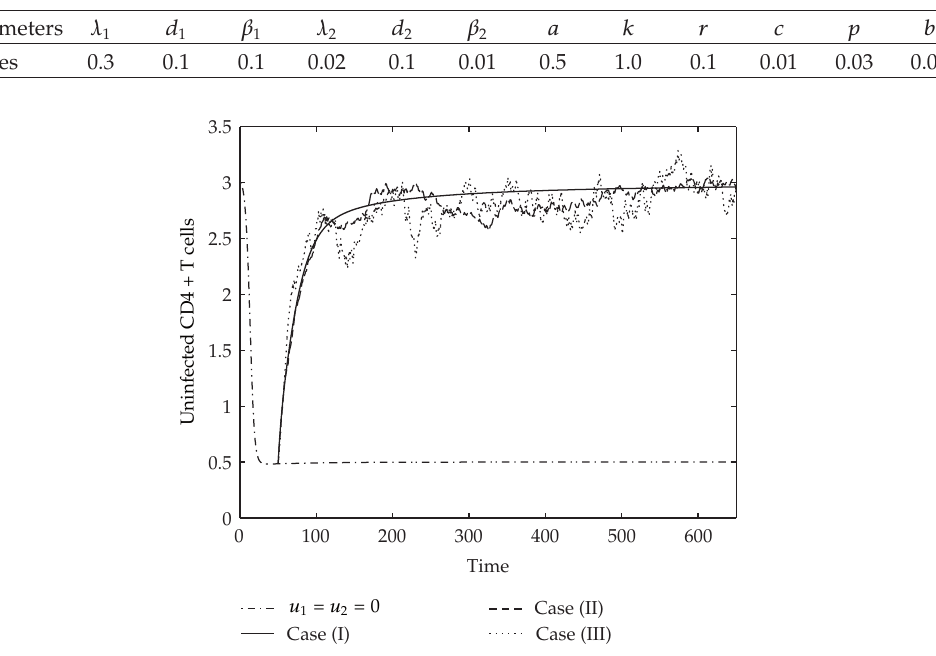
Table 1: The values of the parameters in the HIV infection model.